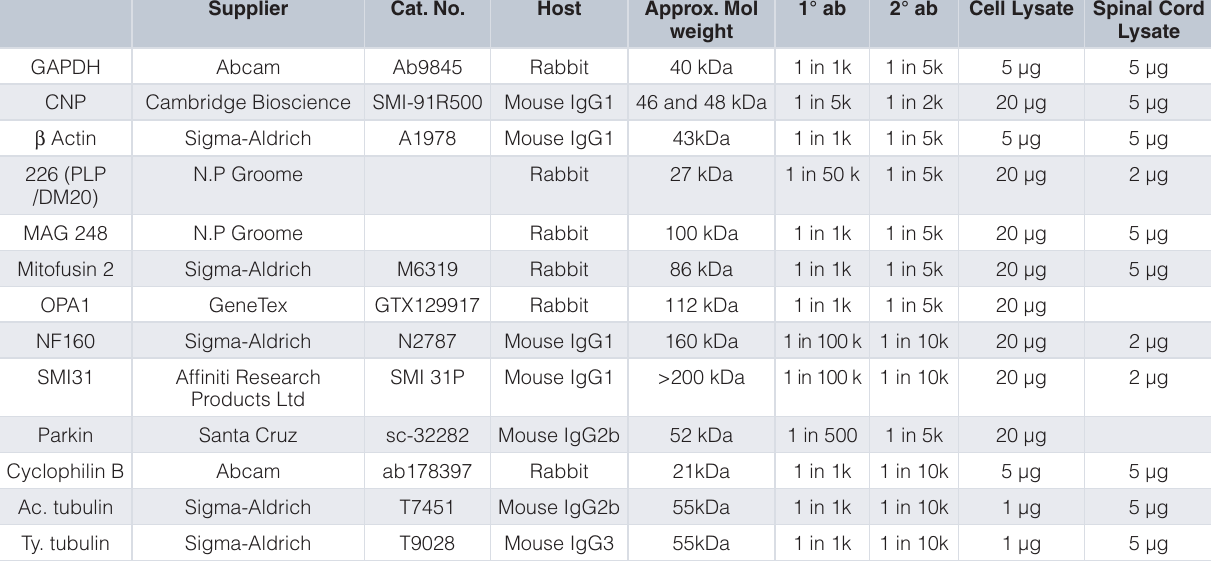
Table 1. Antibody and lysate details for western